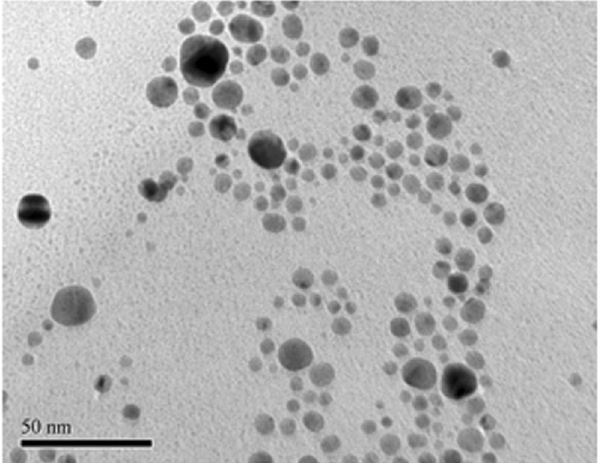
Figure 5. TEM image of as prepared gold nanoparticle. Average diameter is 15